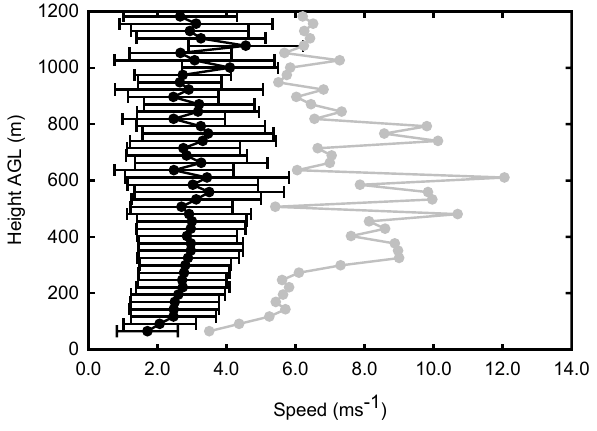
Figure (9) The mean (black circles), maximum (grey circles) and standard Fig. 9. The mean (black circles), maximum (grey circles) and stan- deviation (error bars on the mean plot) of the horizontal wind speed versus dard deviation (error bars on the mean plot) of the horizontal wind height for the period 03/04/08 – 20/06/08 as recorded daily over the time interval 12:00-12:05. speed versus height for the period 3 April 2008–20 June 2008 as recorded daily over the time interval 12:00–12:05. Figure (10) A summary of the various modes of data analysis that have been used to